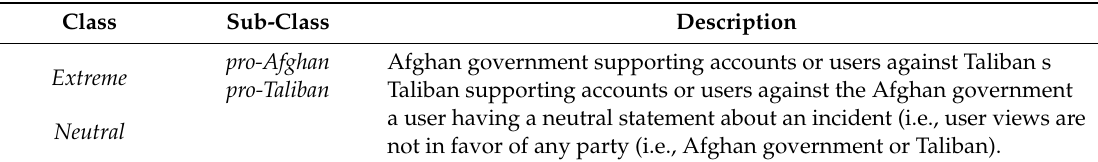
Table 4. Description of assigned classes.